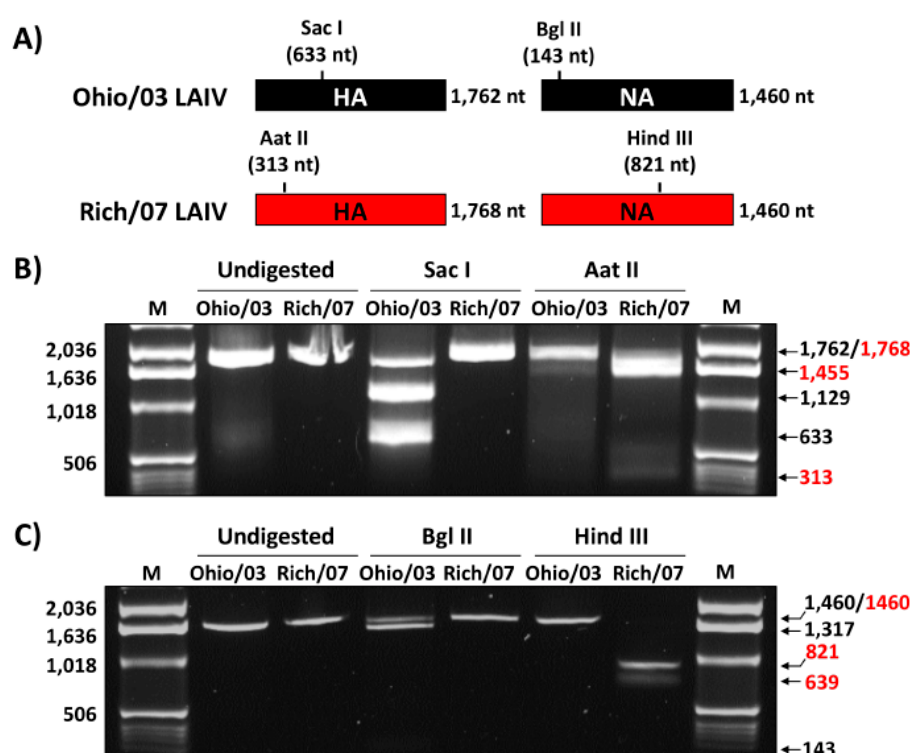
Figure 3. Genotypic characterization of clade 1 Ohio/03 and clade 2 Rich/07 LAIVs: ( A ) Schematic representation of the hemagglutinin (HA; left) and neuraminidase (NA; right) segments from Ohio/03 (black) and Rich/07 (red) LAIVs, indicating the Sac I (Ohio/03) and Aat II (Rich/07); and the Bgl II (Ohio/03) and Hind III (Rich/07) unique restriction sites and their location in the viral HA and NA, respectively. ( B , C ) Madin-Darby canine kidney (MDCK) cells (6 well-plate format, 1 × 10 6 cells/well) were individually infected (MOI 0.1) with Ohio/03 or Rich/07 LAIVs and incubated at 33 °C. At 48 h post-infection (p.i.), total RNA was extracted and the HA ( B ) and NA ( C ) viral segments were amplified by RT-PCR using specific primers. Undigested and Sac I- or Aat II-digested PCR products of HA ( B ) and Bgl II- or Hind III-digested PCR products of NA ( C ) are shown. M: Ladder marker. The nucleotide size of the different bands of the ladder marker is indicated on the left. Nucleotide length of undigested and digested products for Ohio/03 (black) and Rich/07 (red) are indicated on the right.